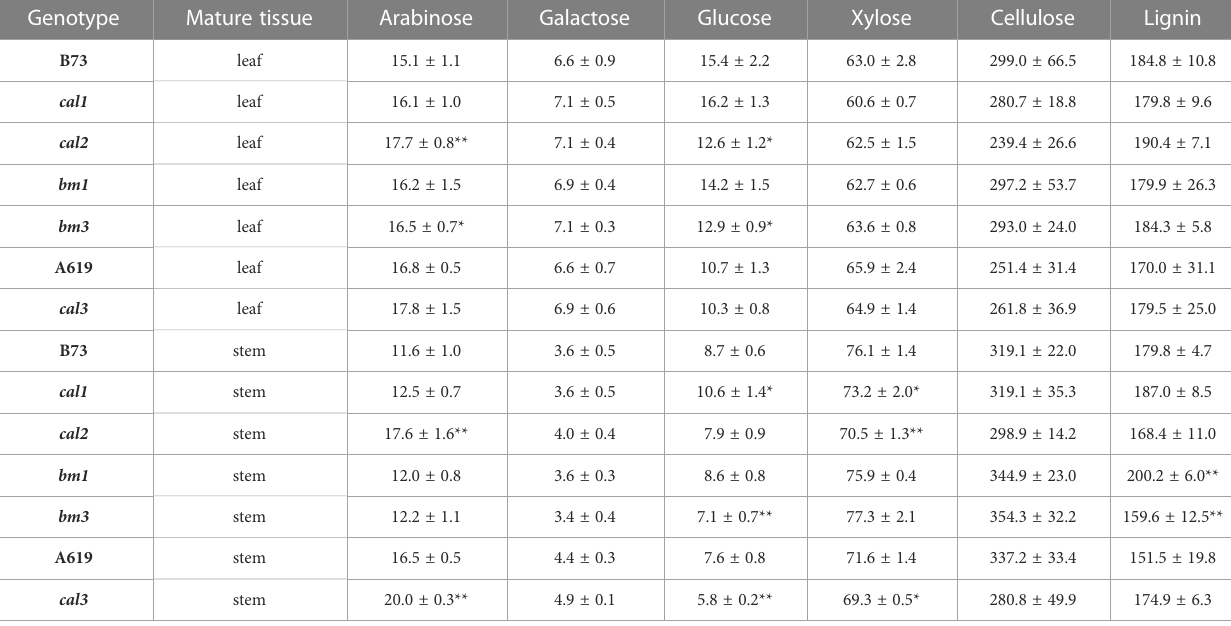
TABLE 3 Cell wall composition of cal mutant mature